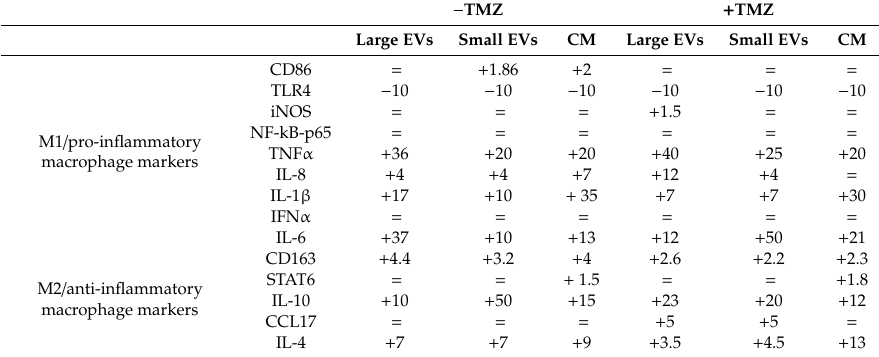
Table 2. Macrophage polarization markers expression following incubation with small and large EVs or CM of TMZ-treated U87 MG cells and non TMZ-treated U87 MG